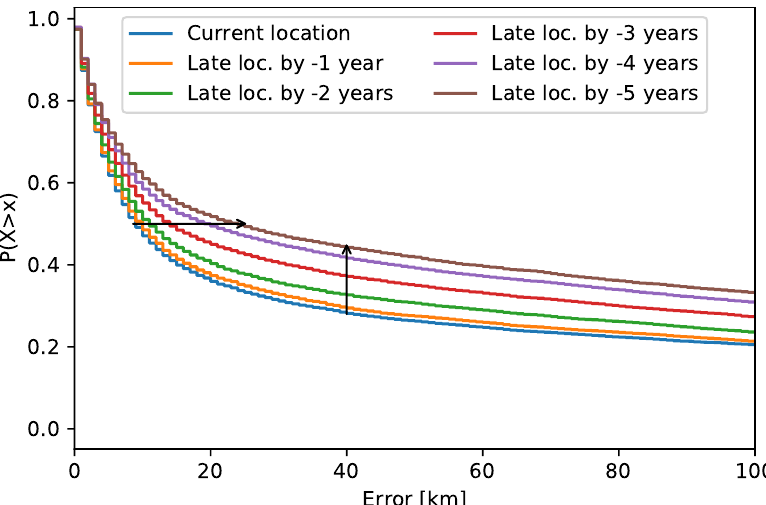
Figure 4. Changes in late location of IPv4 addresses over the years. The arrows show the changes in the location error median and in the percentage of locations outside the city